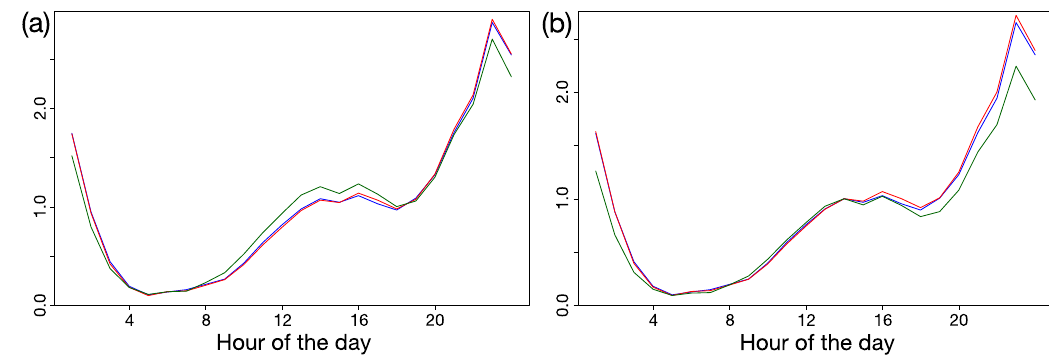
Fig 4. Average curve inside the clusters. (a) Average daily activity curves normalised by the overall daily volume in 3 clusters from the daily texts standard deviation dendrogram. (b) Same average activity curves normalised by the activity at 2 pm.